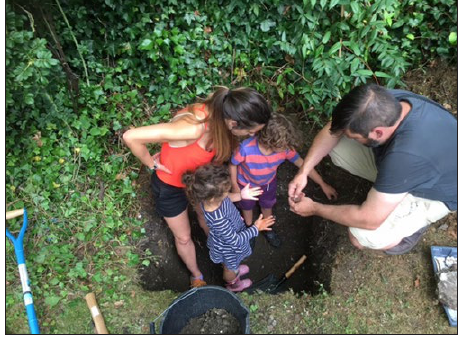
Figure 6: Excavating with local volunteers as part of the Great Bedwyn Research Project (Photo: Stuart